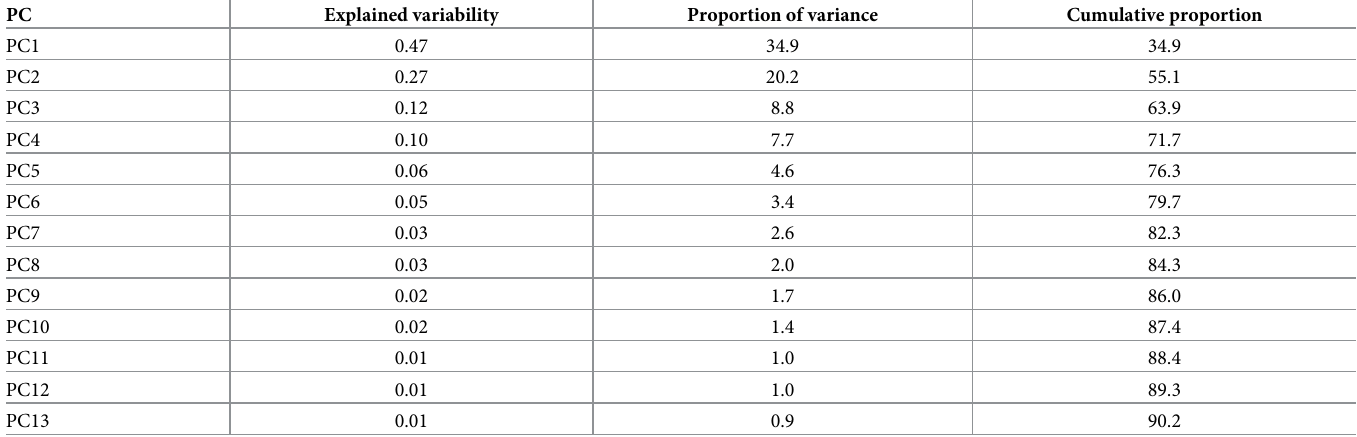
Table 5. Variability report of the first 13 principal components. Proportion of variance and cumulative proportion are percentages. PC stands for principal component.